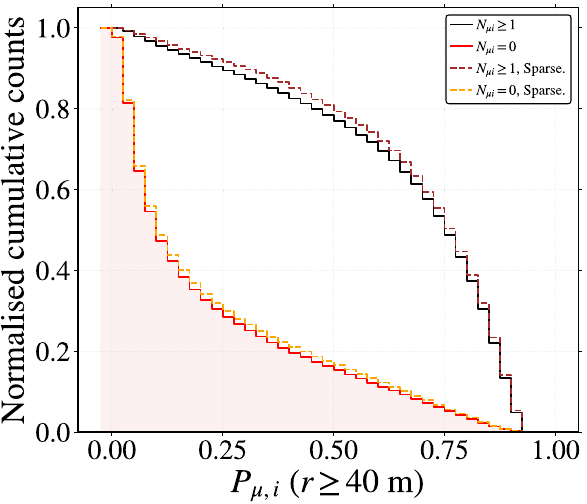
Fig. 6 Reverse cumulative of the distribution for the probability of finding a muon in a WCD station (the result of the CNN). Only stations at a distance higher than 40m from the shower core were considered. Black line is for stations with muons while red line represents stations without muons. Results for the sparse array are also shown in the plot as a dotted